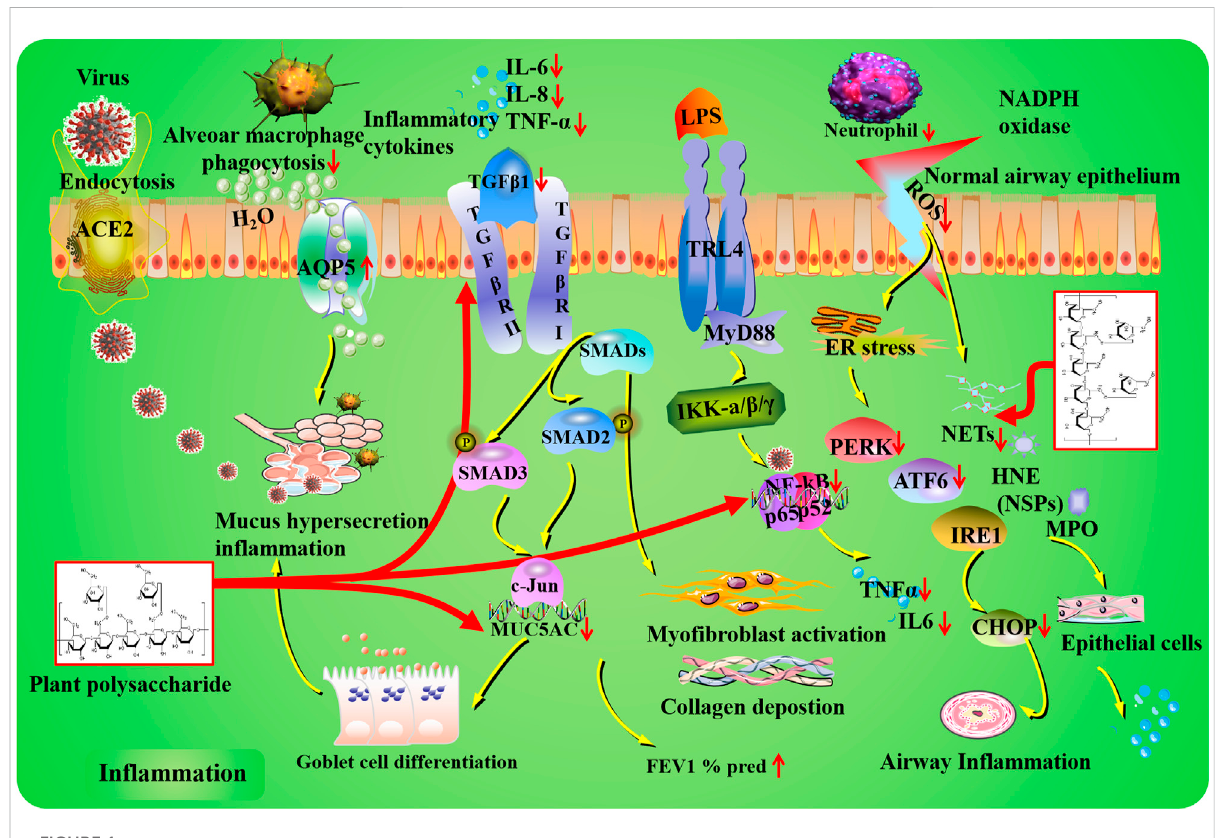
FIGURE 1 In fl ammationmechanismsofplantpolysaccharidesagainstlunginjury.COVID-19induceslungin fl ammation via ACE2(angiotensin-converting enzyme II) receptor-mediated endocytosis into the airway epithelium. Plant polysaccharides have potential regulatory effects on MUC5AC expression, goblet cell differentiation, mucus secretion, and expiratory volume in 1 s percent predicted (FEV1% pred). In the TLR4/NF- κ B signaling pathway, in fl ammatory cytokines can be affected by plant polysaccharides via targeting NF- κ B. Plant polysaccharides could improve airway in fl ammationthroughthemodulationofPERK,ATF6,andCHOP.PlantpolysaccharidescoulddecreaseneutrophillevelsandrestrainNETformation. The TGF- β 1 pathway can be regulated by plant